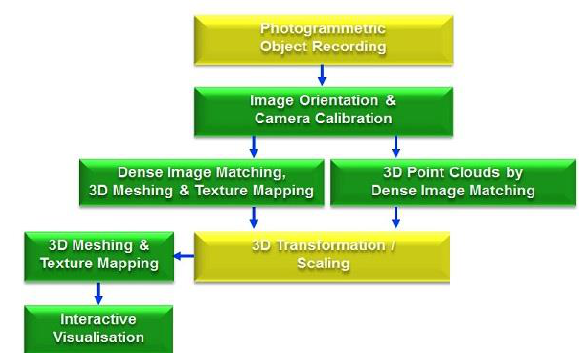
Figure 6. Workflow for image-based low-cost 3D object reconstruction procedures